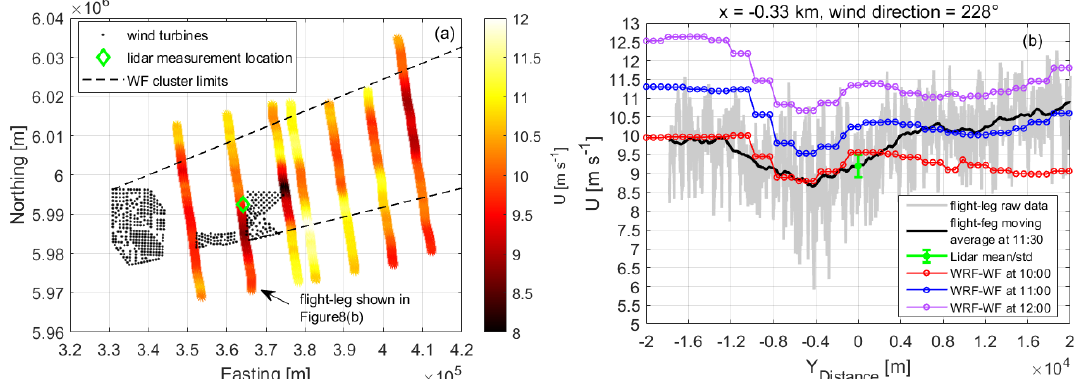
Figure 8. (a) Flight path in the vicinity of the clusters N-2 and N-3 (individual turbines as black points) of the measured wind speed from the measurement flight on 3 July 2020 (10:24–13:02UTC). The black dashed lines indicate the downstream boundaries of the clusters for the measured wind direction of 230 ◦ . The flight altitude during the traversals of the wake clusters was ≈ 120m, and the coordinates refer to UTM WGS84, zone 32. (b) Horizontal wind speed transect for the closest flight traversal upstream of the lidar measurement point ( x = − 0 . 33km, where the negative sign refers to the left of the location of the measurements obtained by scanning lidar) and perpendicular to the wind direction. The gray line represents the 100Hz data, the black line shows the data filtered by a moving average and the green diamond with error bars represents the lidar mean wind speed and its standard deviation for the duration of the flight leg ( ≈ 10min). The red, blue and purple dotted lines show the WRF results with a wind farm parameterization (WRF-WF) from a transect of the model results at 10:00, 11:00 and 12:00UTC, respectively, based on the flight coordinates.